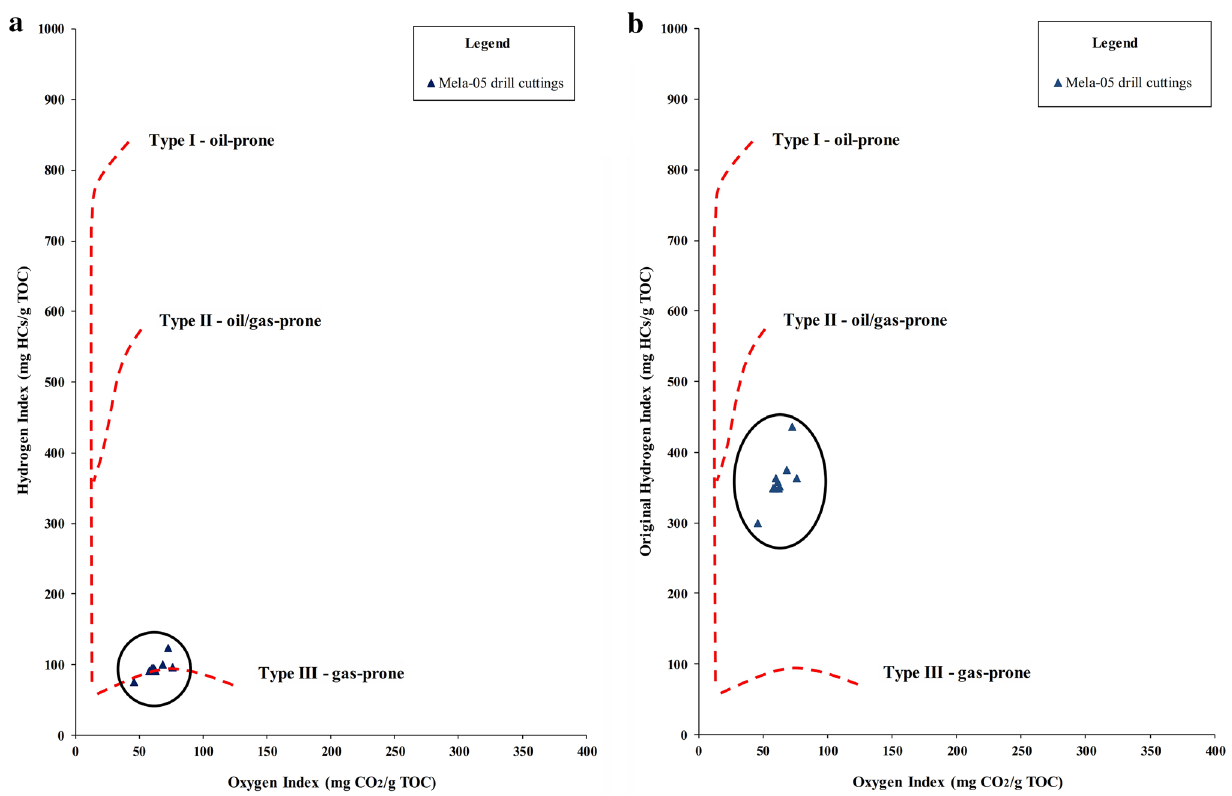
Fig. 3 a The HI versus OI cross-plot (modified after Van Krevelen Diagram), showing the present kerogen type in the Mela-05 drill cut- tings of the Chichali Formation (after Espitalié et al. 1977). b The